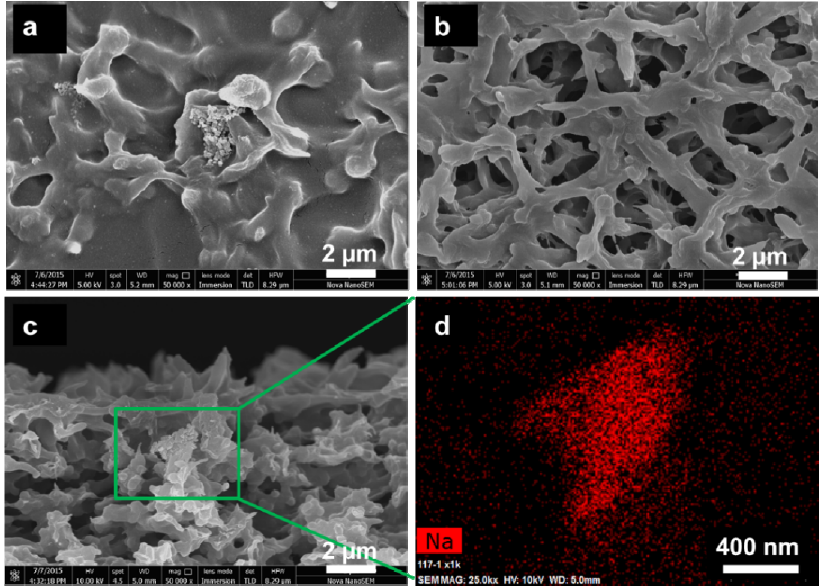
Figure 3. SEM and EDX autopsy of the composite membrane after 96 h pervaporation test (membrane with MR of 0.2). ( a ) Feed side, ( b ) permeate side and ( c ) cross ‐ section of the composite membrane; and ( d ) EDX mapping the membrane cross ‐ section beneath the PVA coating layer.